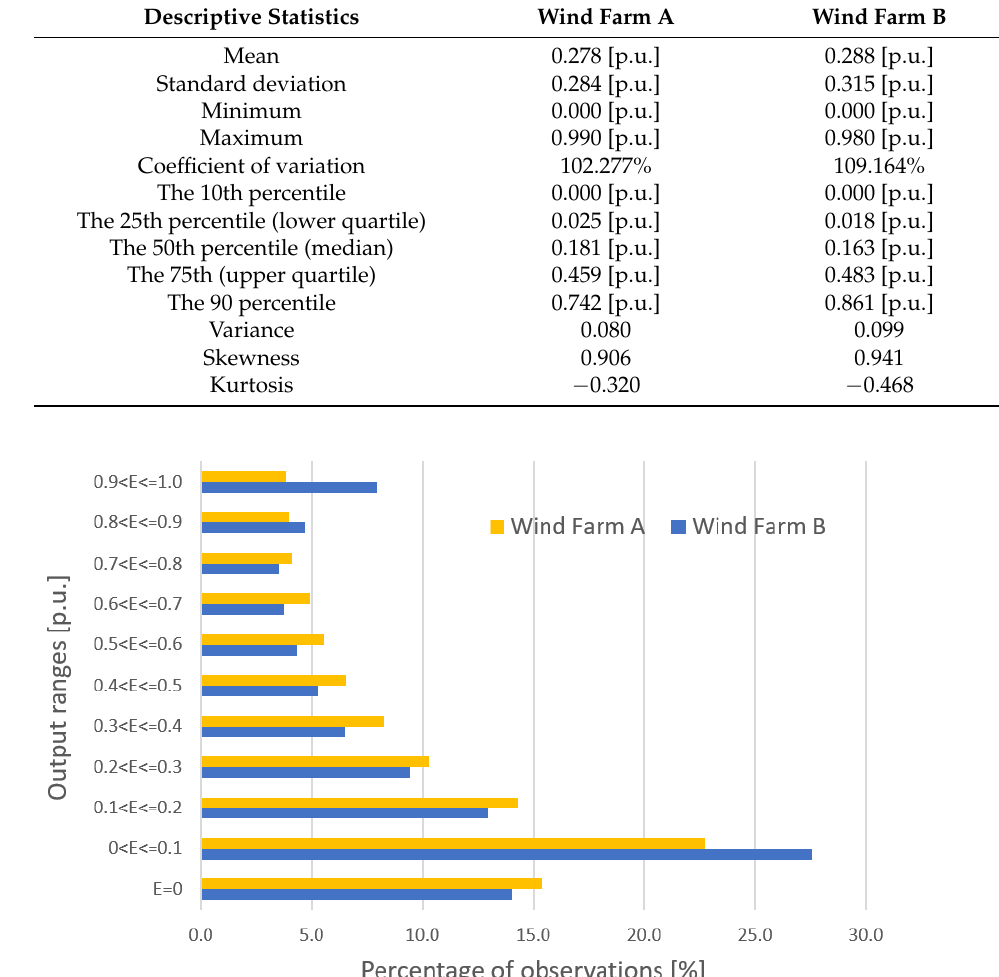
Table 1. Descriptive statistics for hourly electric energy generation.